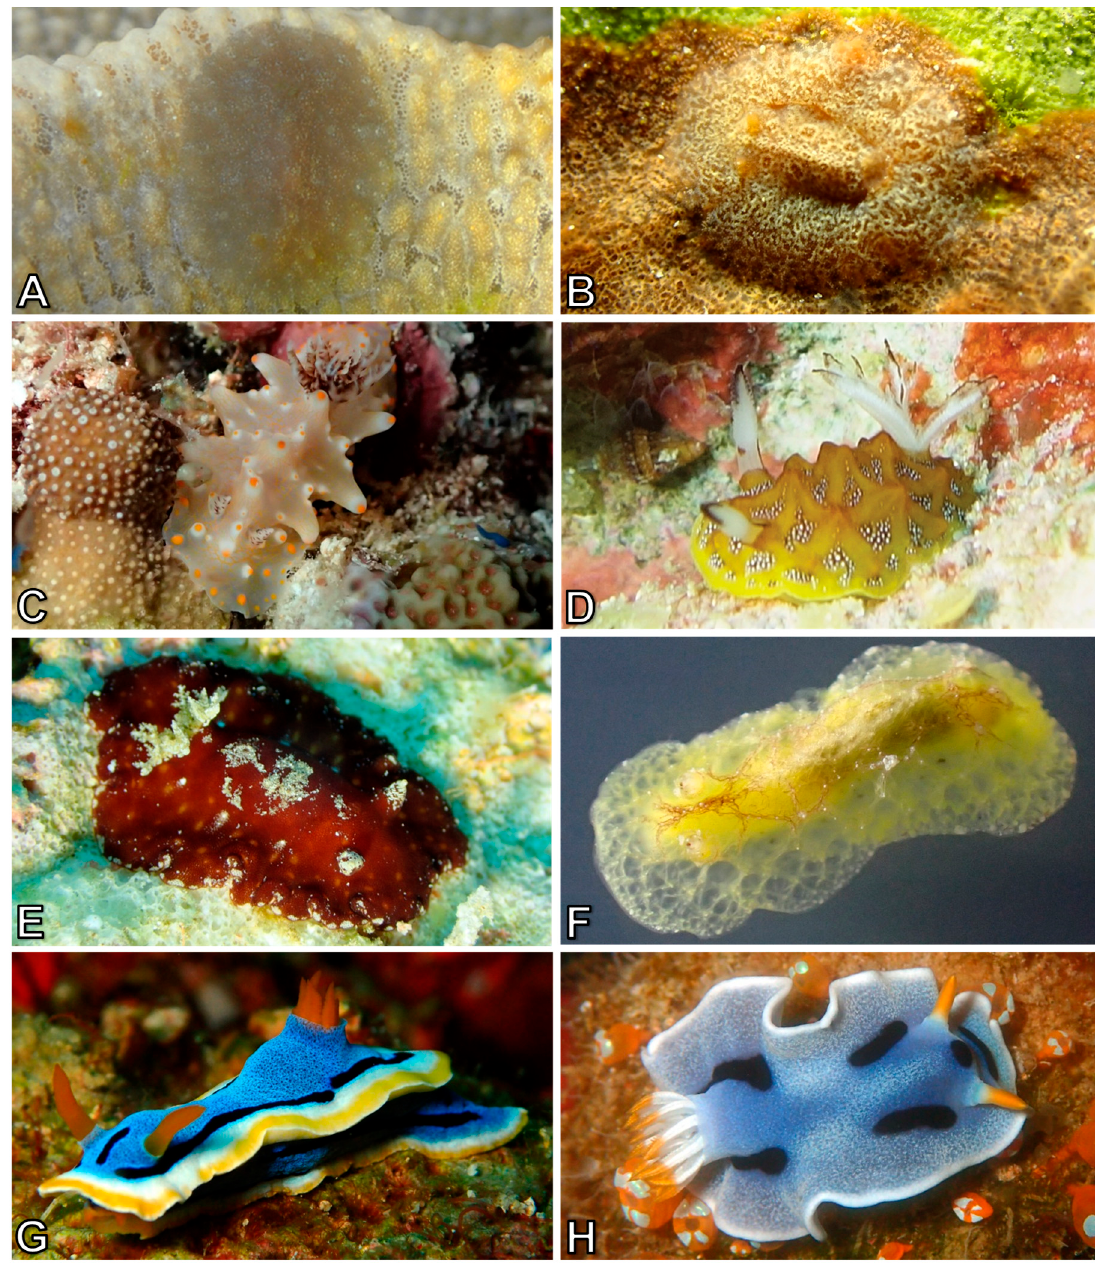
Figure 8. Nudibranchia - Doridina: ( A ) and ( B ) Asteronotus mimeticus ; ( C ) Halgerda batangas ; ( D ) Halgerda tessellata ; ( E ) Platydoris sanguinea ; ( F ) Sclerodoris spec. ( Sclerodoris sp. 2 in Gosliner et al. [11]: 195), Scsp2_16Bu-1; ( G ) Chromodoris annae ; ( H ) Chromodoris dianae .